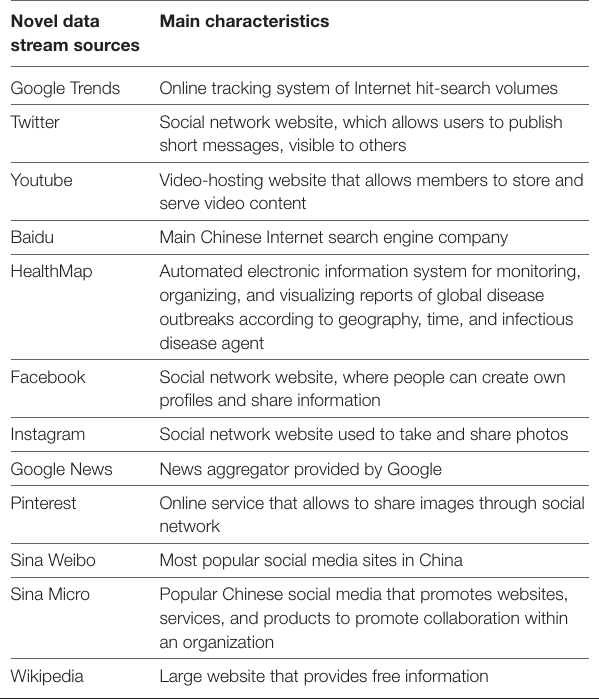
taBLe 1 | Search strategy: inclusion/exclusion criteria, keywords, and filter applied.